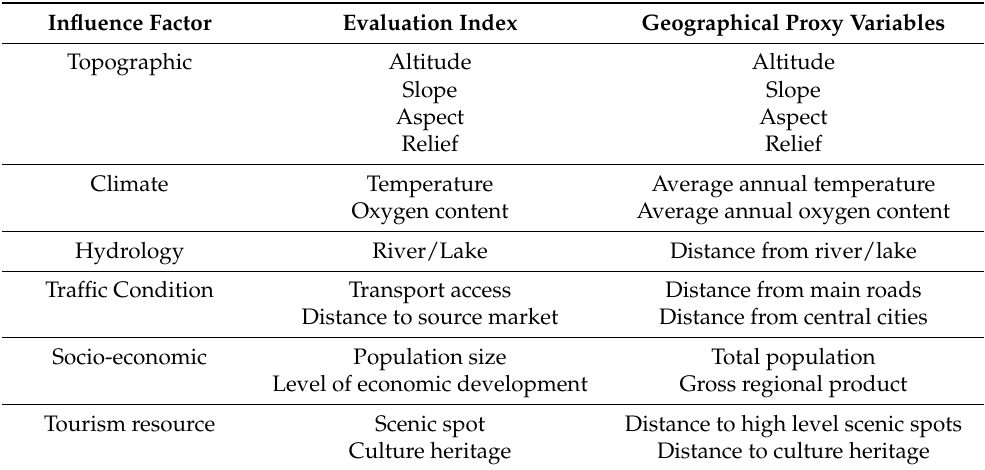
Table 1. Influencing factors of spatial distribution of the RT